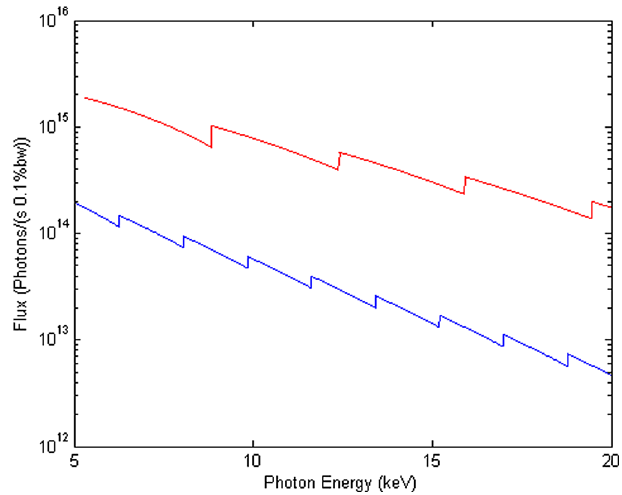
FIG. 4. Existing (black) vs new dynamic aperture (cyan) calculated at the injection point (no errors).